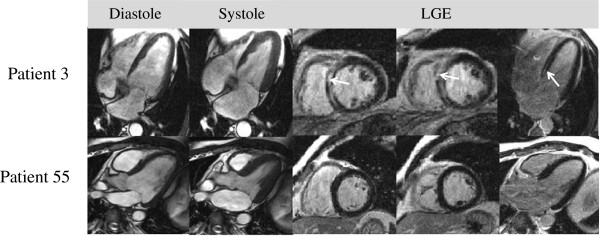
Patients with histologically proven myocarditis, but different CMR results and outcomes. Patient 3 EMB demonstrated myocarditis with low copy numbers of PVB19. CMR revealed impaired ventricular function (LV-EF 36%) in an enlarged left ventricle (EDV 190 ml) and septal LGE. The patient suffered SCD during follow-up. Patient 55 suffered from chest pain and abnormal fatigue, blood chemistry returned an elevated troponin. EMB revealed chronic myocarditis with intramyocardial presence of HHV6 and PVB19, but CMR was completely normal. This patient did not suffer any events and did not report any cardiac symptoms at follow-up.